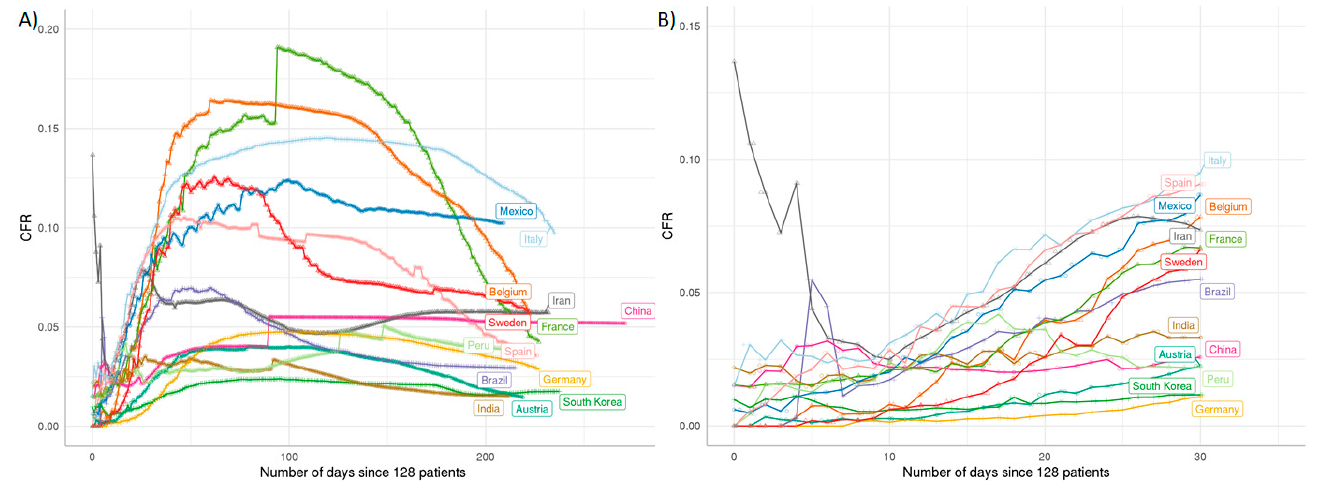
Figure 3. Case fatality rate (CFR) comparison of SARS-CoV-2 infection over time. The CFR values over time are illustrated by the curves, specific colors indicate individual countries as labeled in the same color. ( A ): CFR over time for individual countries until October 2020. The dramatic rise of most curves after the early phase indicates partly that the public health system of a country may have reached its maximum limit of treatment capability. The dropping tendency of each curve indicates the public health system keeps recovering from the early crisis. ( B ): enlarged view up to day 30 allows close inspection of the early phase of infection spread. The figure is de novo generated using the public data from RKI/Tencent, processed by the R/nCov2019 script [22].